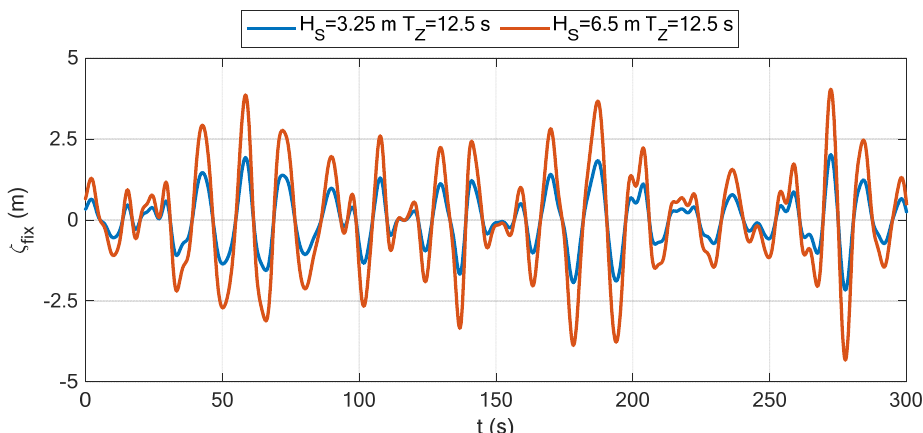
Figure 2. Time history of the two irregular wave trains (in the inertial reference frame).